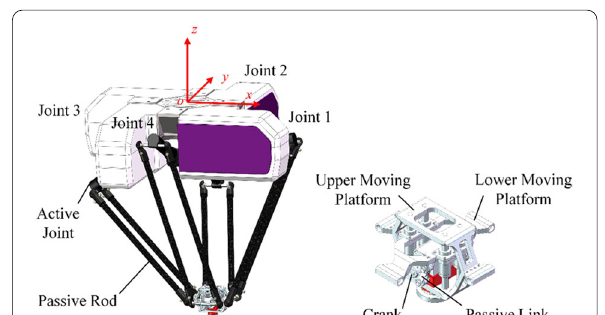
Figure 7 3D view of the SR4 parallel